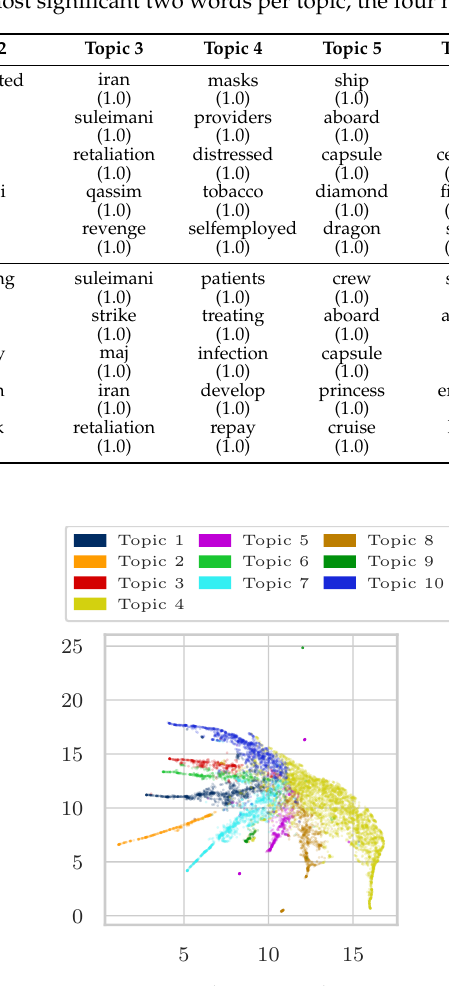
Table A22. For the most significant two words per topic, the four nearest neighbors based on cosine similarity are listed.